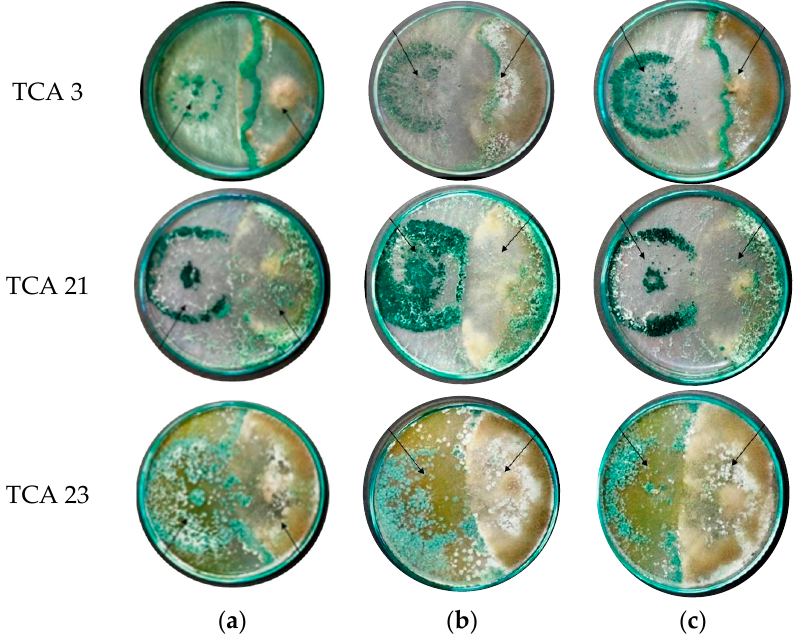
Figure 3. In vitro antagonism of the three native Trichoderma strains (TCA 3, 21, 23) against Botrytis sp. in dual culture. Each Trichoderma previously grew in different concentrations of chlorpyrifos: 960 mg/L ( a ), 1200 mg/L ( b ), and 1440 mg/L ( c ).